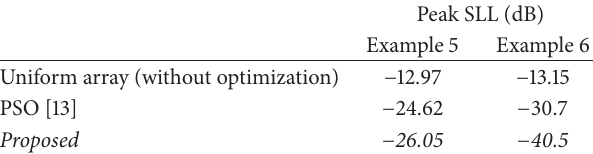
Table 11: Benchmarking results for peak SLL minimization.